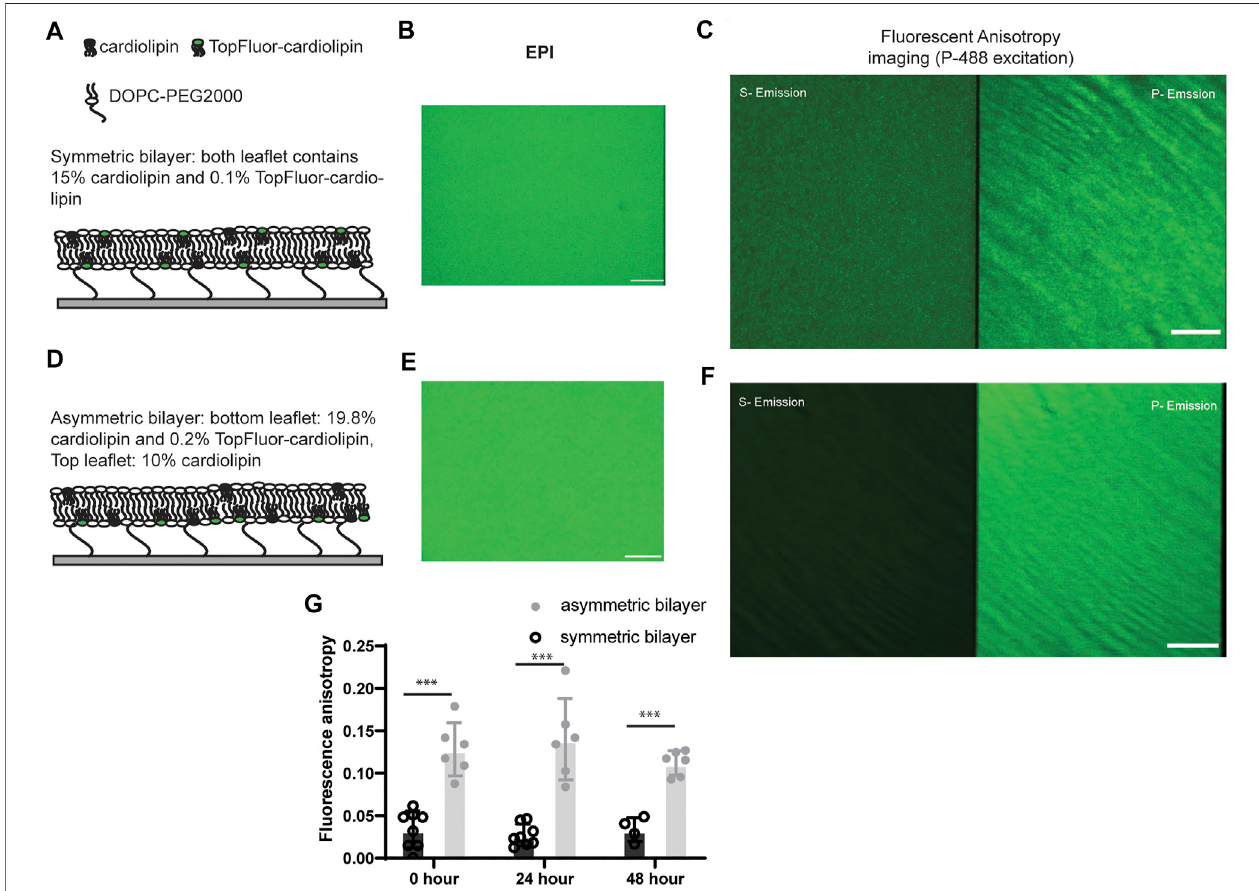
FIGURE 1 | Scheme for symmetric and asymmetric polymer-supported bilayers and evaluation of cardiolipin asymmetry by fl uorescence anisotropy. Bilayers with symmetric and asymmetric CL distribution (A, D) show no difference in fl uorescence emission intensity under EPI- fl uorescence illumination (B, E) . However, under polarizedexcitation( P polarization )the fl uorescenceintensityofPandSemissionchannelsshowsigni fi cantdifferences (C,F) .Fluorescenceanisotropymeasurementsover time (G) show that bilayer asymmetry was stable over a 48 h time period. Scale bar of each image: 10 µm. Data were collected from four bilayers at fi ve random locations collected from each bilayer (ns, p > 0.05; *, p ≤ 0.05; **, p ≤ 0.01; ***, p ≤ 0.001; ****, p ≤